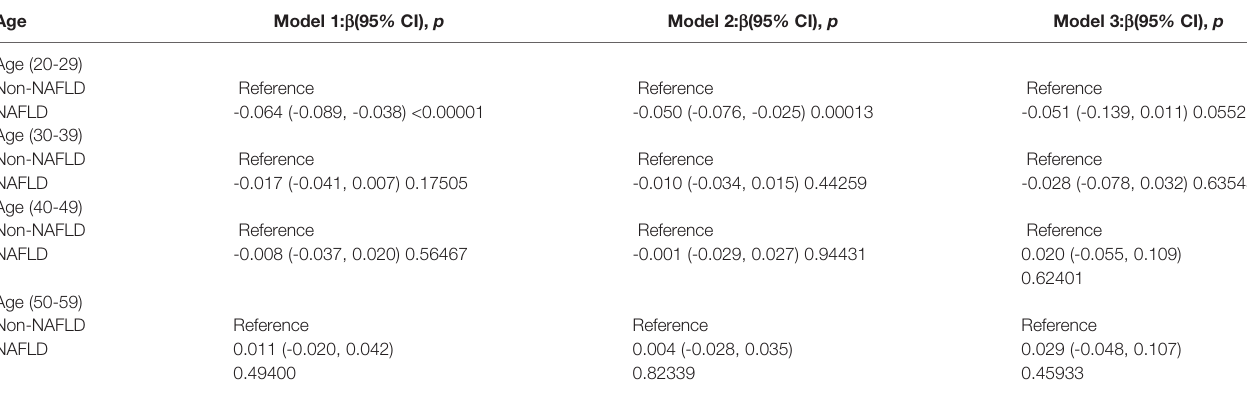
Model 1: No covariates were adjusted. Model 2: Age, gender, race were adjusted. Model 3: Age, gender, race, body mass index, poverty to income ratio, education, smoking behavior, Moderate activities, Diabetes status, Waist circumference, HbA1c (%), Total cholesterol, Triglyceride, LDL- cholesterol, HDL- cholesterol, ALT, ALP, GGT, AST, Serum creatinine, Serum iron, Lumbar bone mineral density, CAP and LSM were adjusted. *In the subgroup analysis strati fi ed by gender or race, the model is not adjusted for the strati fi cation variable itself.